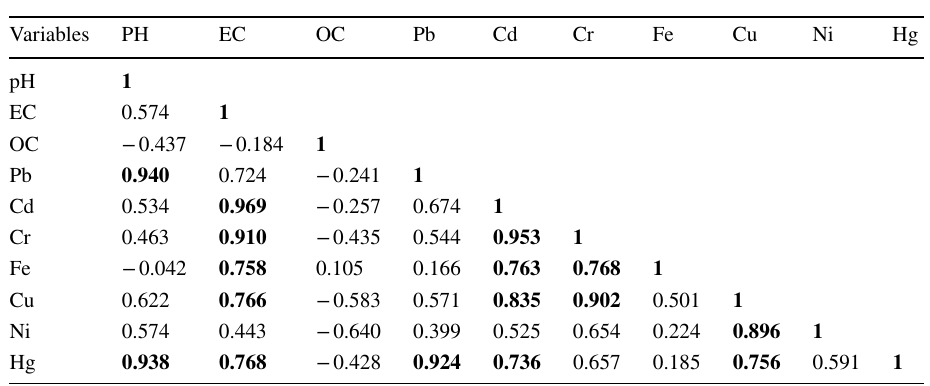
Values in bold are different from 0 with a significance level alpha